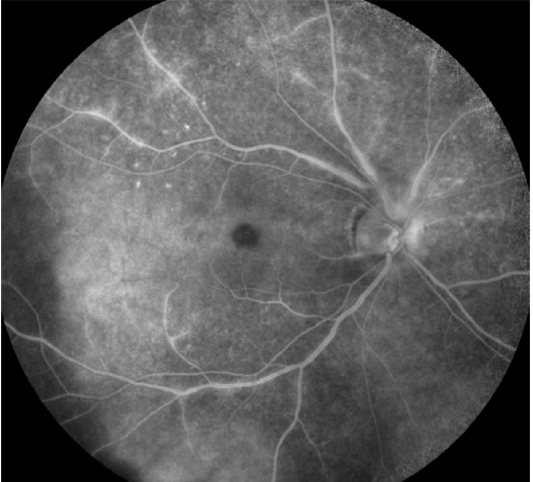
Figure 3. The figure is a fluorescein angiogram (FA) that shows a patient with multifocal retinitis and retinal vasculitis due to ocular syphilis. The FA shows multifocal retinal vasculitis involving the large vessels and multiple areas of hyperfluorescence due to retinitis lesions. There is mild disc hyperfluorescence as well.